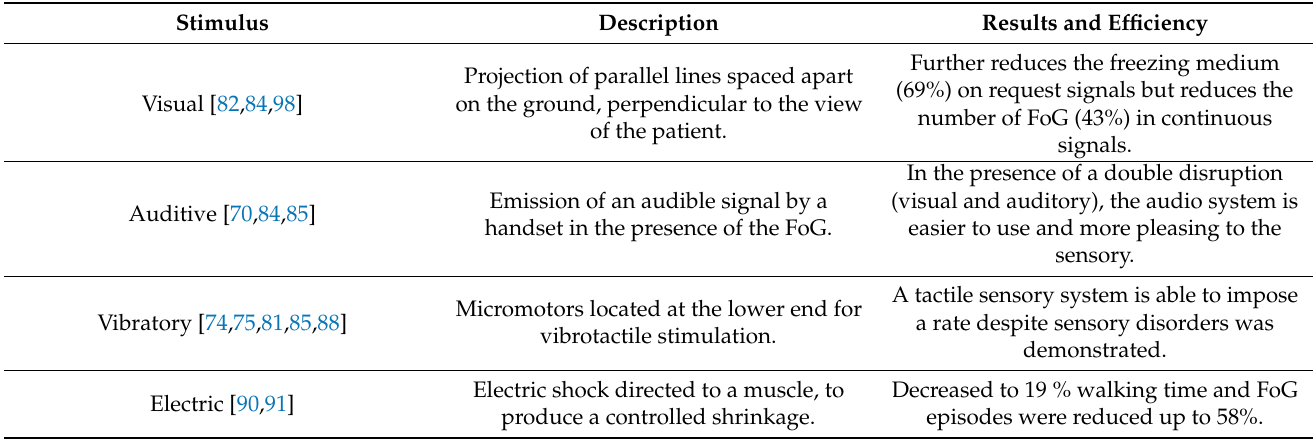
Table 3. Description of devices developed until today to help patients with episodes of FoG based in the used